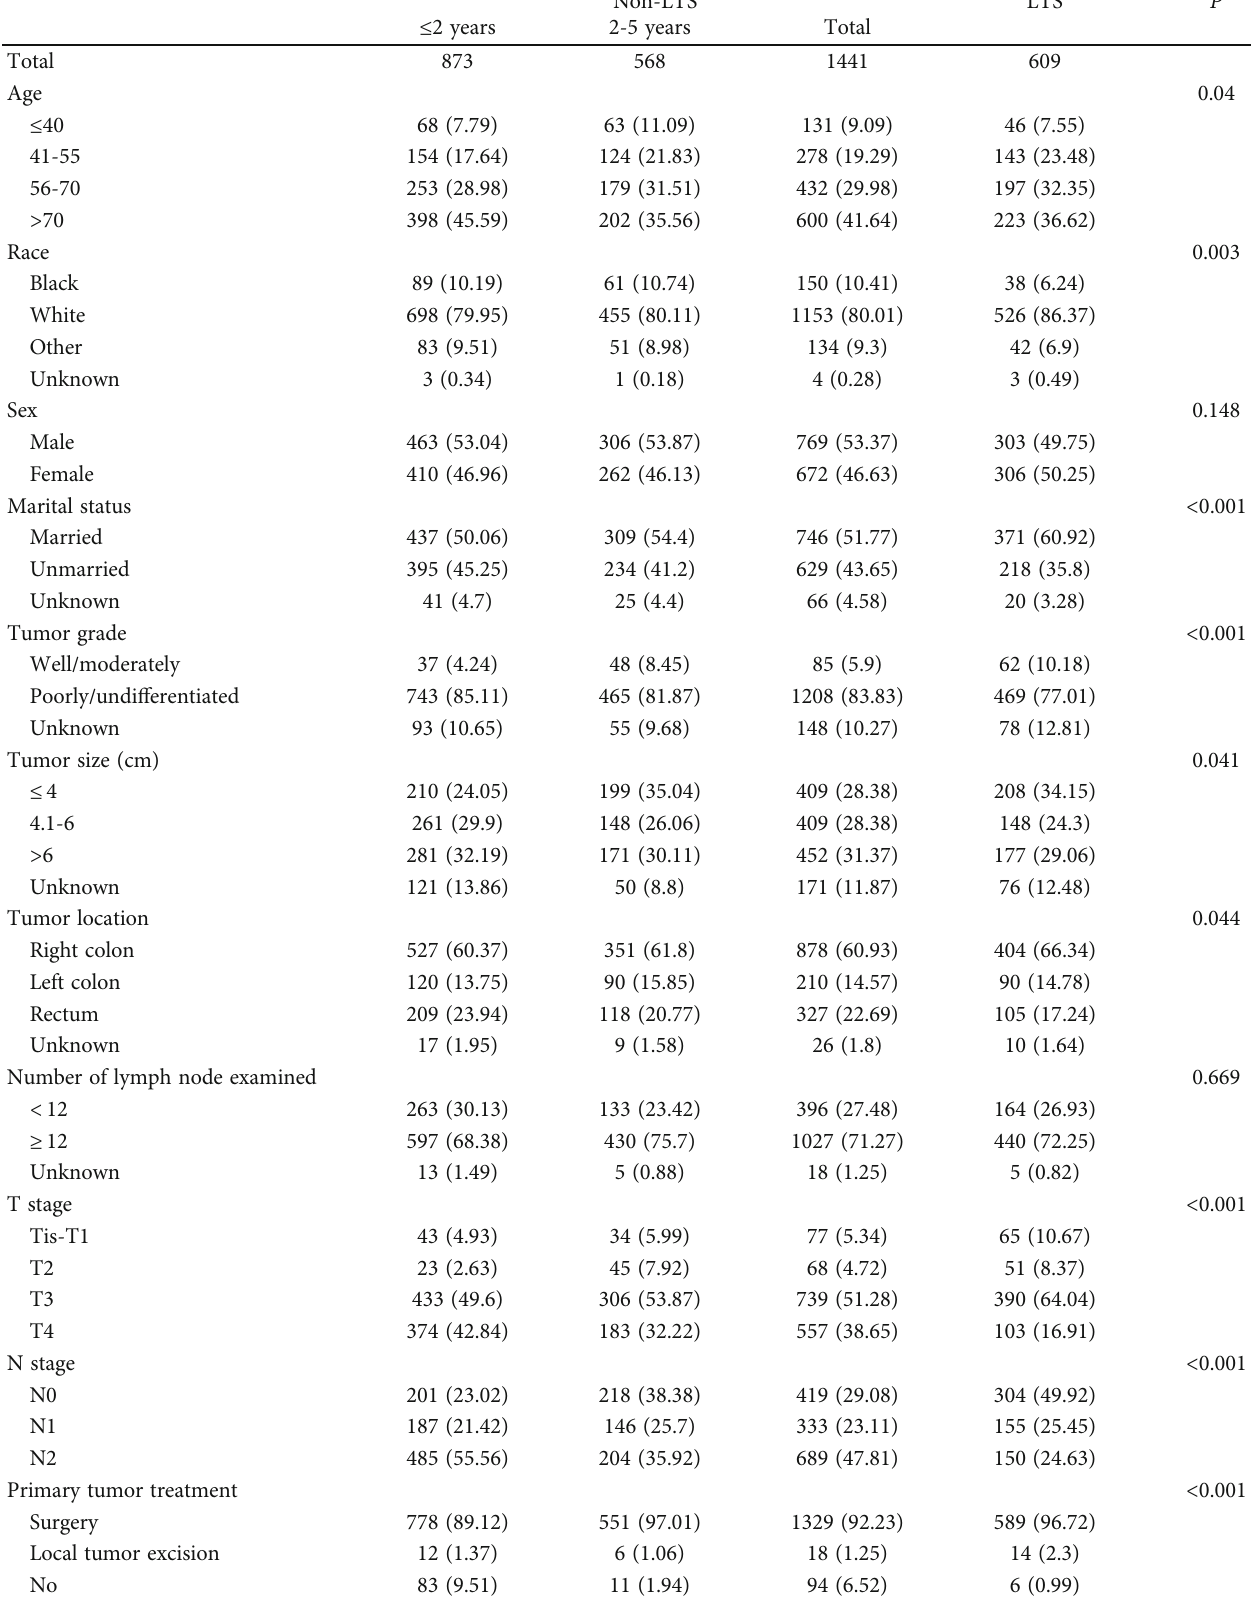
Table 1: Di ff erences of clinicopathological characteristics between non-LTS † and LTS among patients with nonmetastatic colorectal SRCC ‡